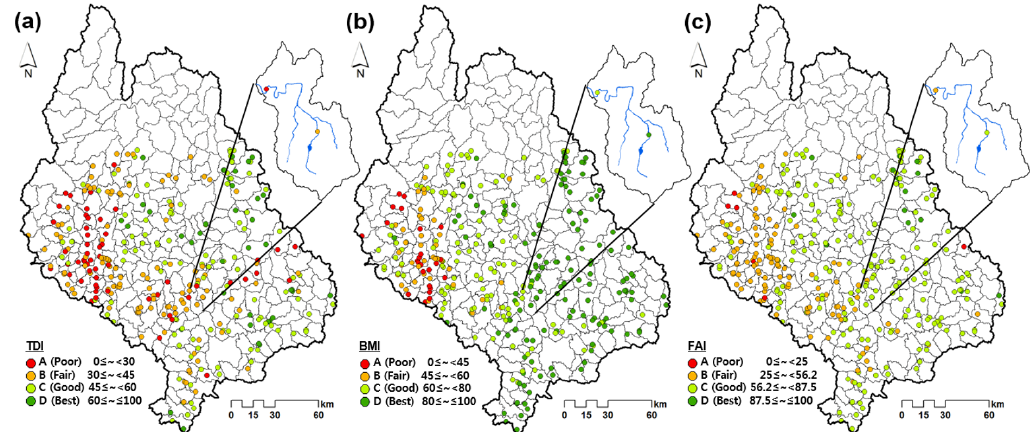
Figure 8. Biological conditions of the (a) FAI, (b) BMI, and (c) FAI according to the observed monitoring data for the period from 2008 to 2013 in the Han River